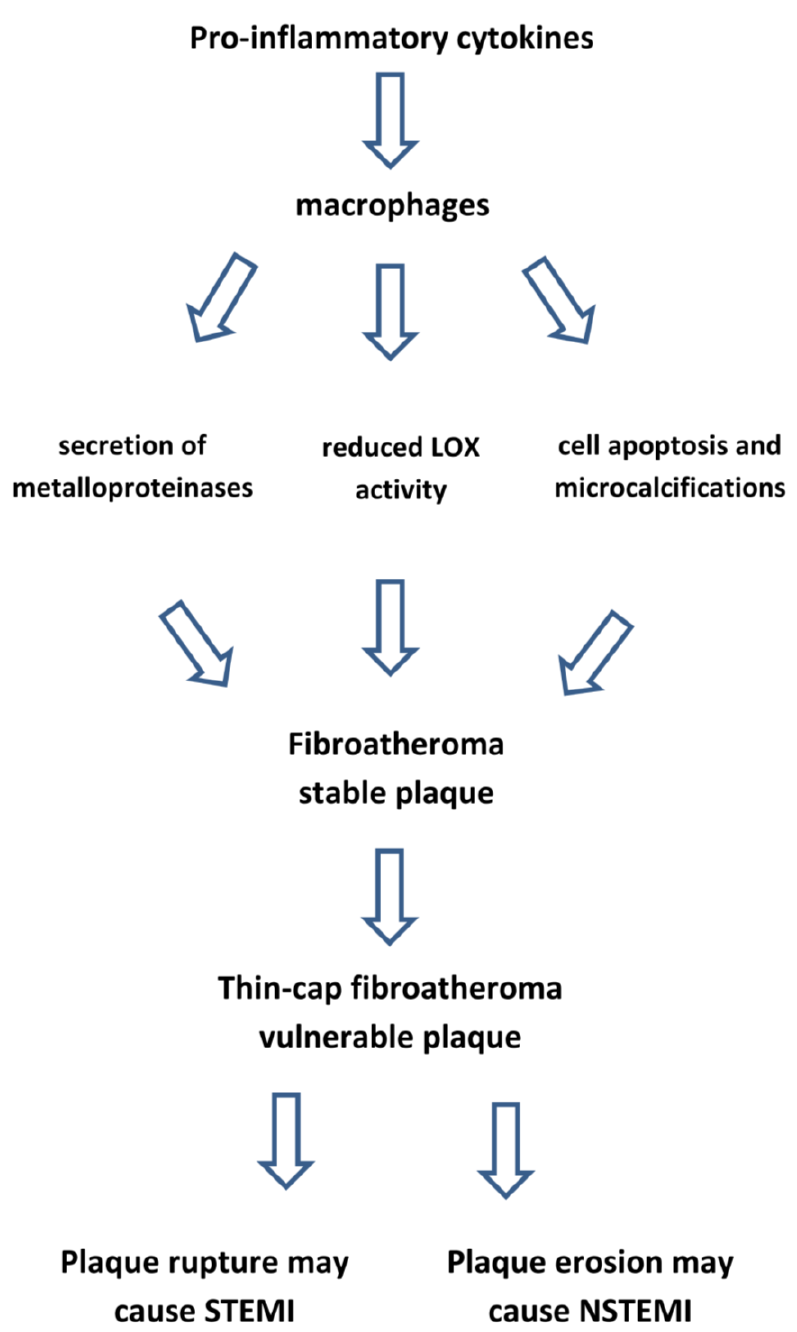
Figure 8. Inflammation makes atherosclerotic plaque vulnerable. LOX: lysyl oxidase enzyme. STEMI: ST-segment elevation myocardial infarction. NSTEMI: Non-ST-segment elevation myocardial infarction.